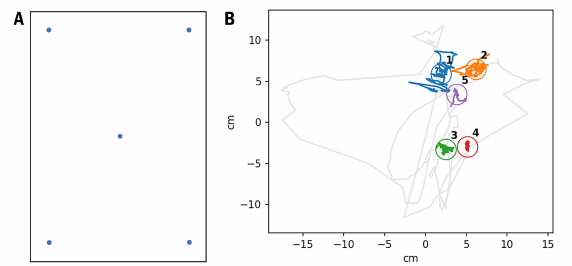
Figure 1. Oken Reader precision and accuracy. A. IPad screenshot with five calibration dots. B. An example of a raw gaze track for one of the respondents with identified calibration